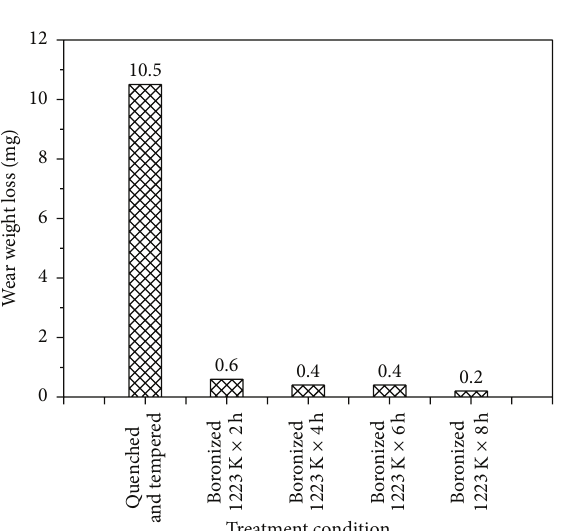
Figure 6: ln 𝐾 versus 1/ 𝑇 for boronized GCI.